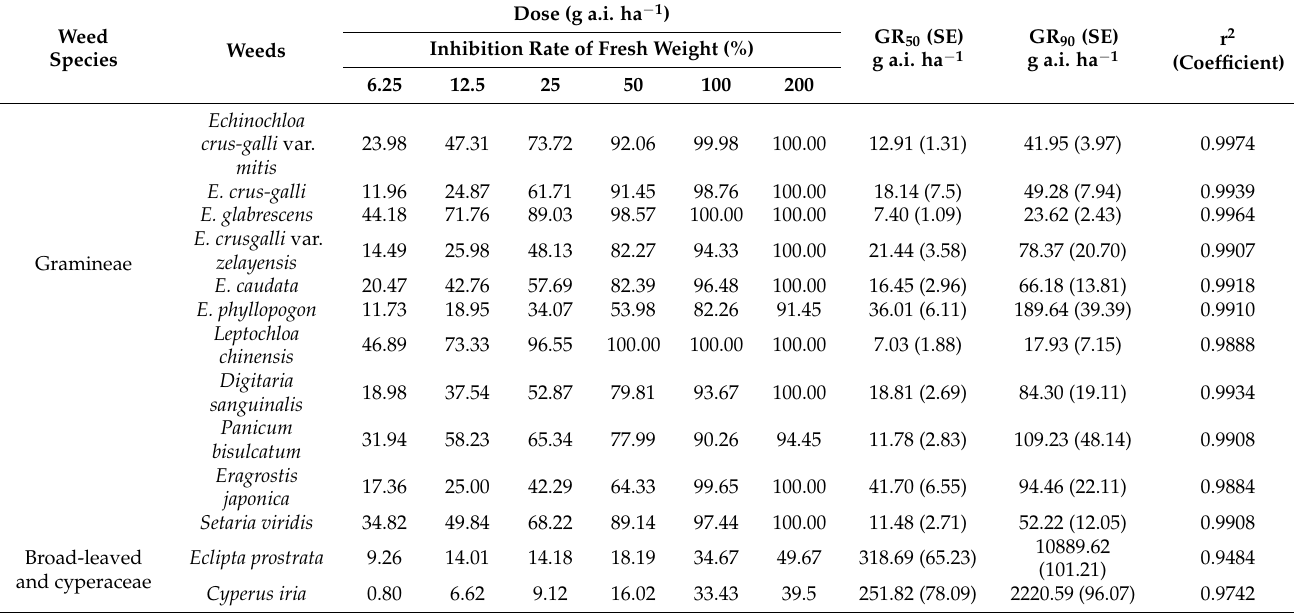
Table 3. Effect of Glyamifop on common weeds in the paddy